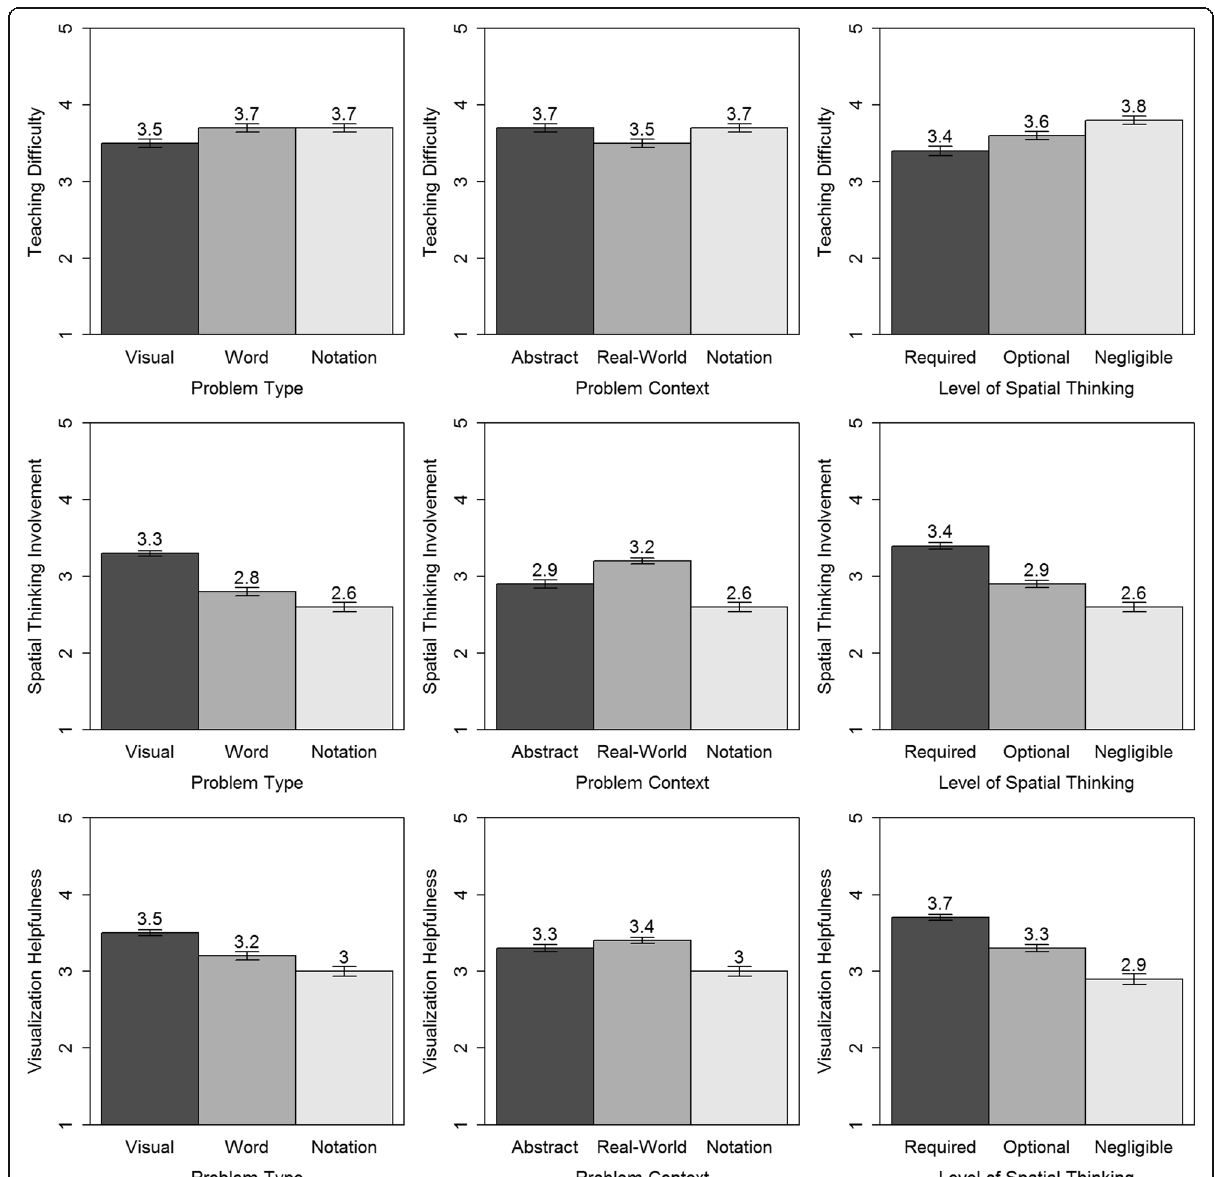
Fig. 3 Math categorization by problem type (left column), problem context (center column), and level of spatial thinking (right column). Each by ratings of teaching difficulty (top row), spatial thinking involved (middle row), and helpfulness of visualizations (bottom row). Each graph contains mean values and error bars using the standard error of the